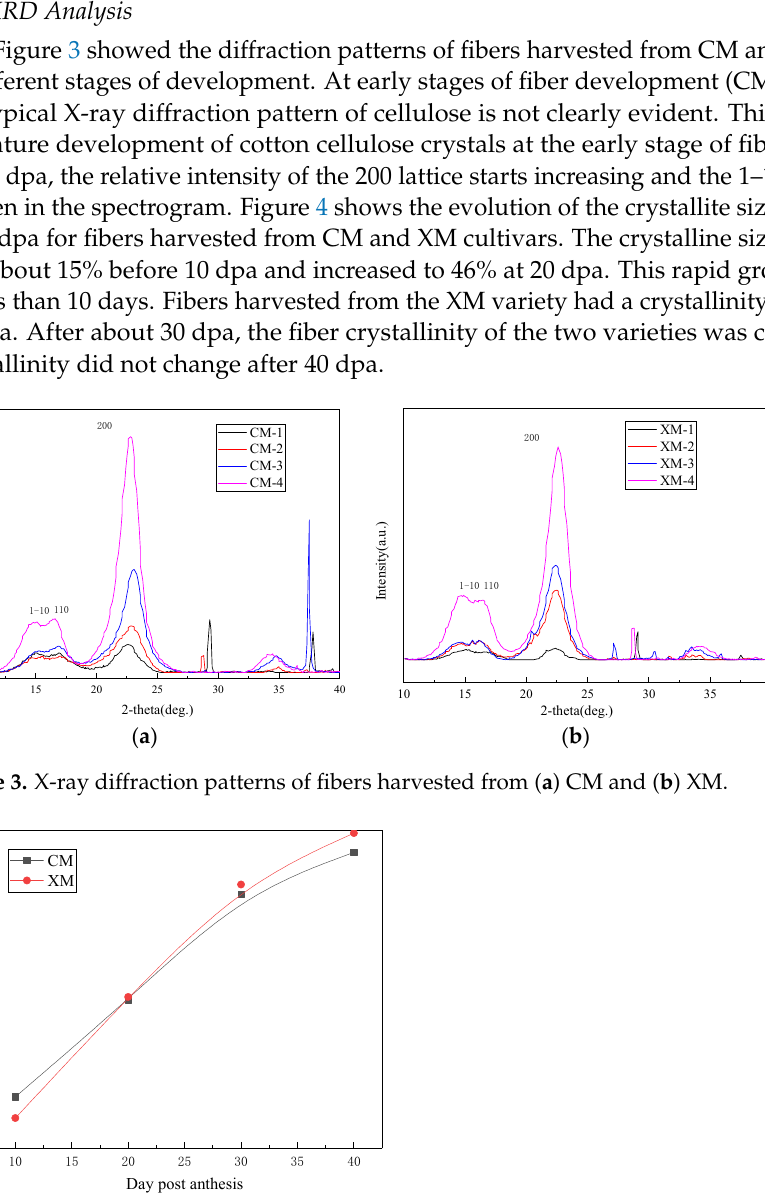
Figure 2. FTIR spectra of fibers harvested at different developmental stages from CM ( a ) and XM ( b ) cultivar.